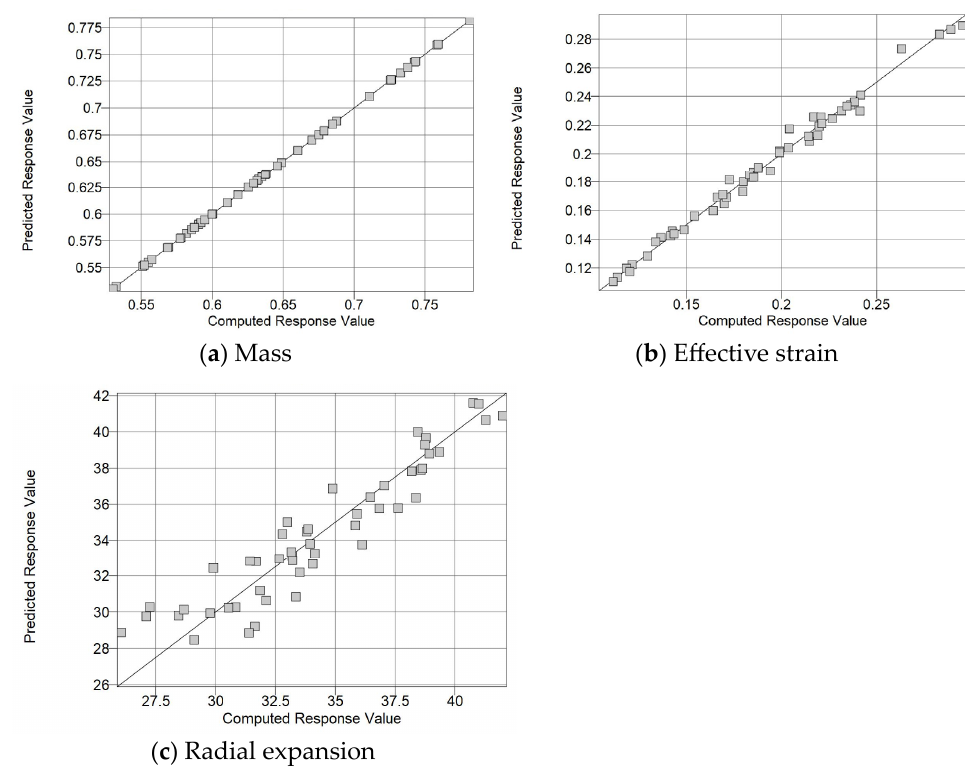
Figure 12. Comparison between the simulation result and the predicted value.